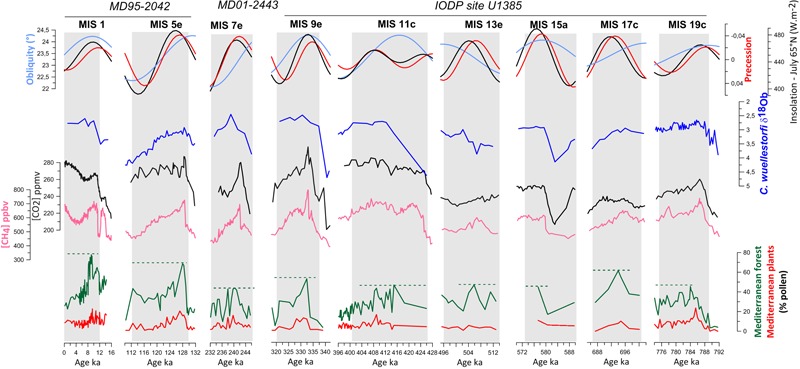
Pollen and isotopic (δ18Ob) records from the southwestern Iberian margin (Sánchez Goñi et al., 1999, 2016b; Roucoux et al., 2006; Chabaud et al., 2014; Hodell et al., 2015; Oliveira et al., 2016; and unpublished data). The Mediterranean forest is mainly composed of deciduous oaks and Mediterranean plants, i.e., sclerophyllous trees and shrubs such as Quercus ilex type (holm oak, kermes oak), Q. suber type (cork oak), Olea (olive tree), Phillyrea, Pistacia, and Cistus (rockroses). Pollen data are compared to CO2 and CH4 records from ice cores (Siegenthaler et al., 2005; Spahni et al., 2005; Loulergue et al., 2008; Luthi et al., 2008) and astronomical forcing (Berger, 1978). Adapted from Desprat et al. (2017).